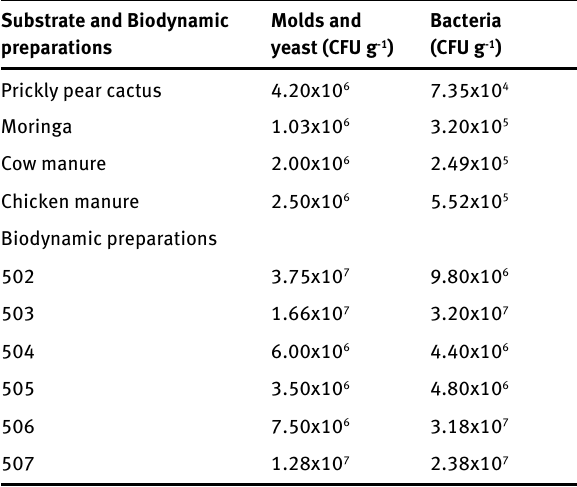
Table 2: Total molds, yeast and bacteria (CFU g -1 compost) in princi- pal substrates and biodynamic preparations used in static piles Substrate and